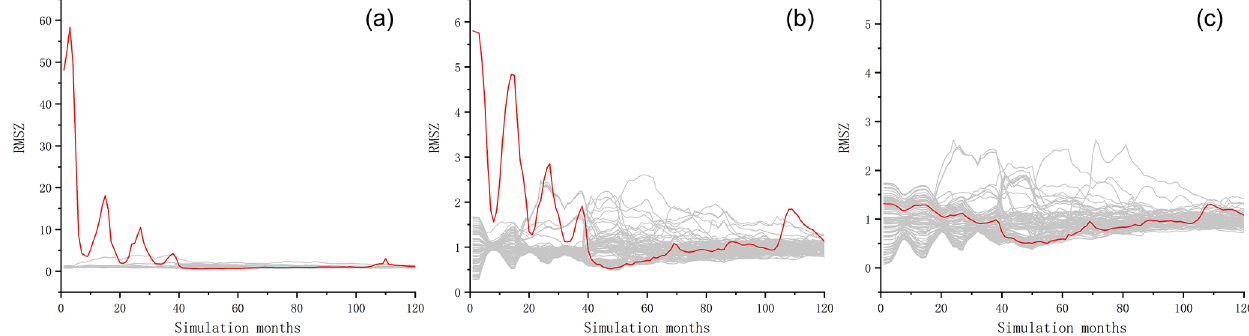
Figure 7. RMSZ biases of the sea surface temperature in ensemble experiments (gray lines) with perturbation coefficient of (a) O( 10 − 14 ) , (b) O( 10 − 11 ) and (c) O( 10 − 10 ) and in the mixed-precision experiment (red line).